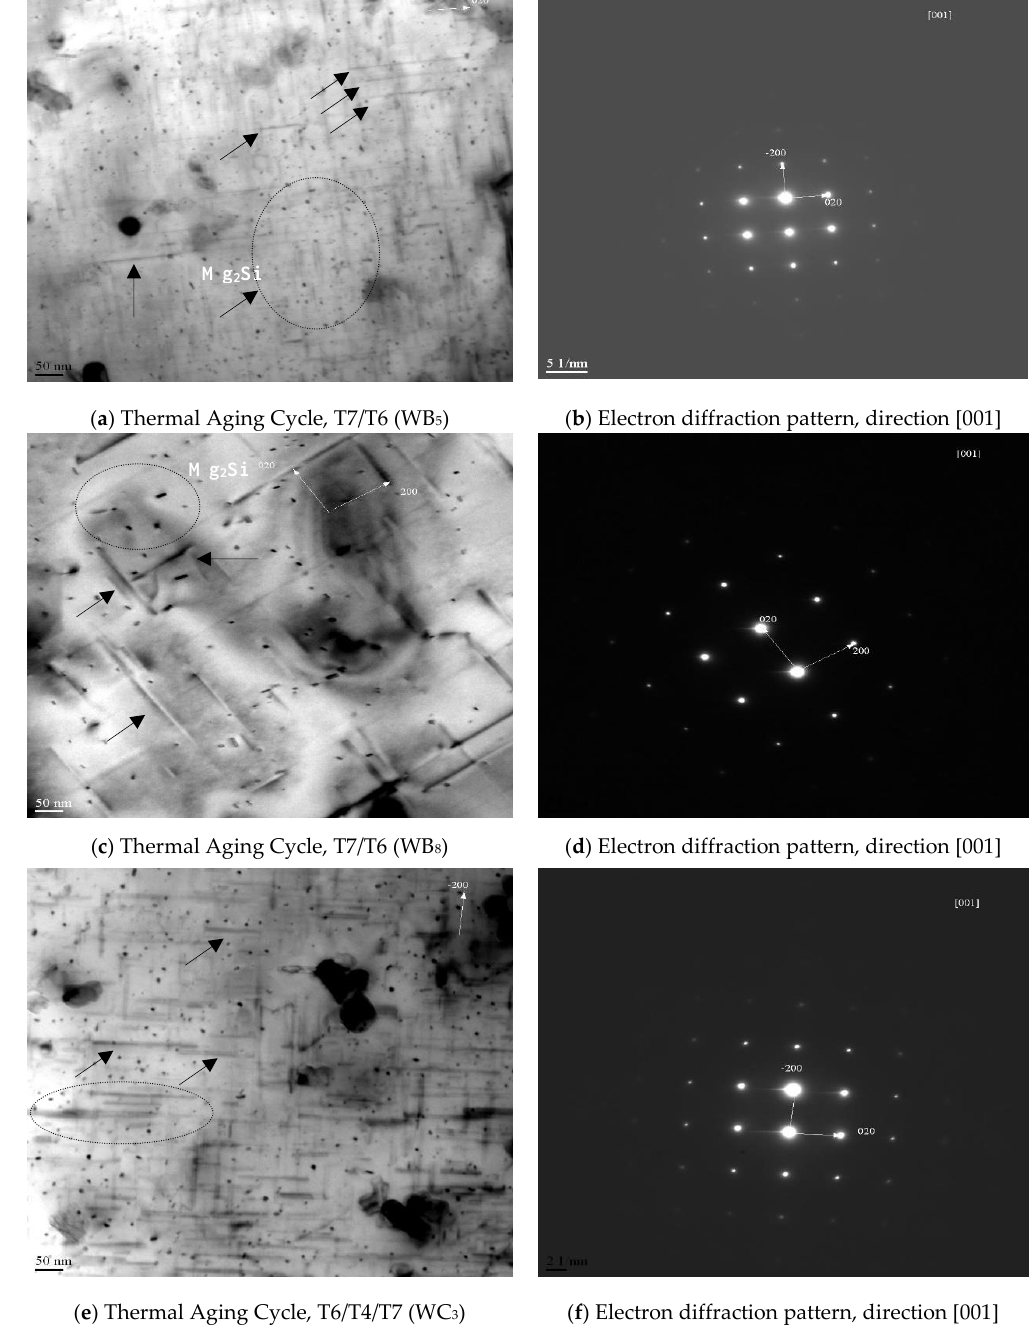
Figure 6. TEM micrographs showing the formation of different sizes of Mg 2 Si precipitates of A357-SSM heat treating by multiple and interrupted thermal aging cycles. ( a ) Thermal Aging Cycle, T7/T6 (WB 5 ), ( b ) Electron diffraction pattern, direction [001], ( c ) Thermal Aging Cycle, T7/T6 (WB 8 ), ( d ) Electron diffraction pattern, direction [001], ( e ) Thermal Aging Cycle, T6/T4/T7 (WC 3 ), ( f ) Electron diffraction pattern, direction